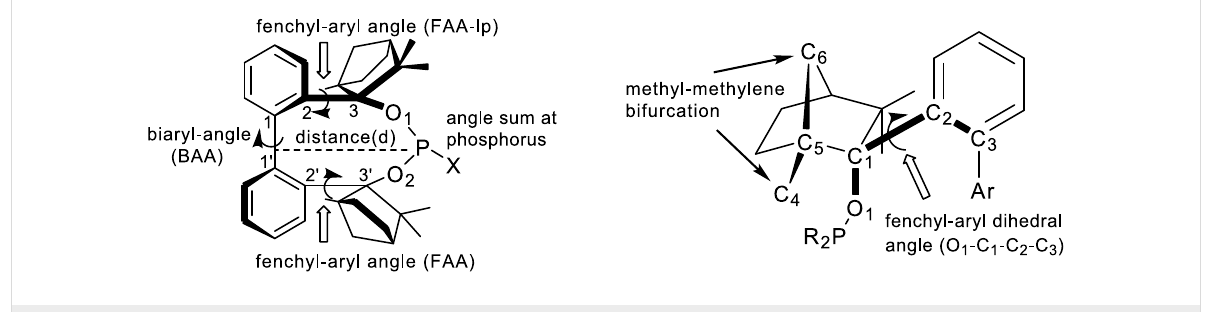
Scheme 4: Geometries of BIFOP-systems with respect to biaryl dihedral angles (C 2 -C 1 -C 1’ -C 2’ , BAA), fenchyl-aryl dihedral angles (C 1 -C 2 -C 3 -O 1 ) on the lone pair-side of phosphorus (FAA-lp) and at the substituent (X) side (FAA), the pyramidality of phosphorus measured as angle sum and the distance of phosphorus to the biaryl axis (C 1 -C 1’